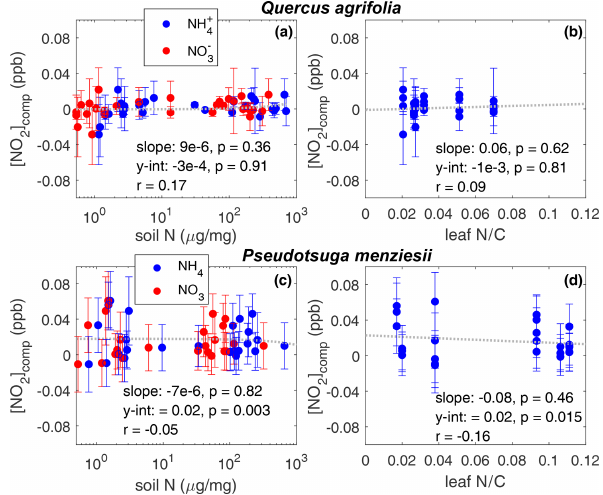
Figure 5. The concentration below which leaves emit NO 2 is the compensation point ([NO 2 ] comp ). [NO 2 ] comp is plotted against the soil nitrogen concentration in the form of NH + and NO − for (a) Q. 4 3 agrifolia and (c) P. menziesii . The dashed line shows a linear fit to NH 4 data. The relationship is not significantly different ( α = 0 . 05) when fit to NO − data. [NO 2 ] comp is plotted against the leaf nitro- 3 gen:carbon ratio for (b) Q. agrifolia and (d) P. menziesii . On each panel the Pearson’s correlation coefficient, the slope, the intercept, and their p values are shown. The amount of soil and leaf nitrogen has no significant impact on the compensation